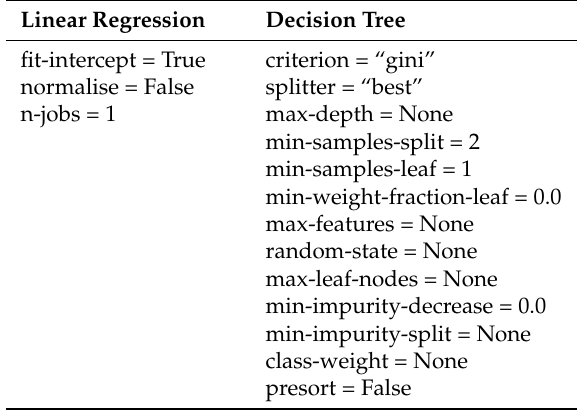
Table 2. Default parameters of the linear regression and decision tree algorithms